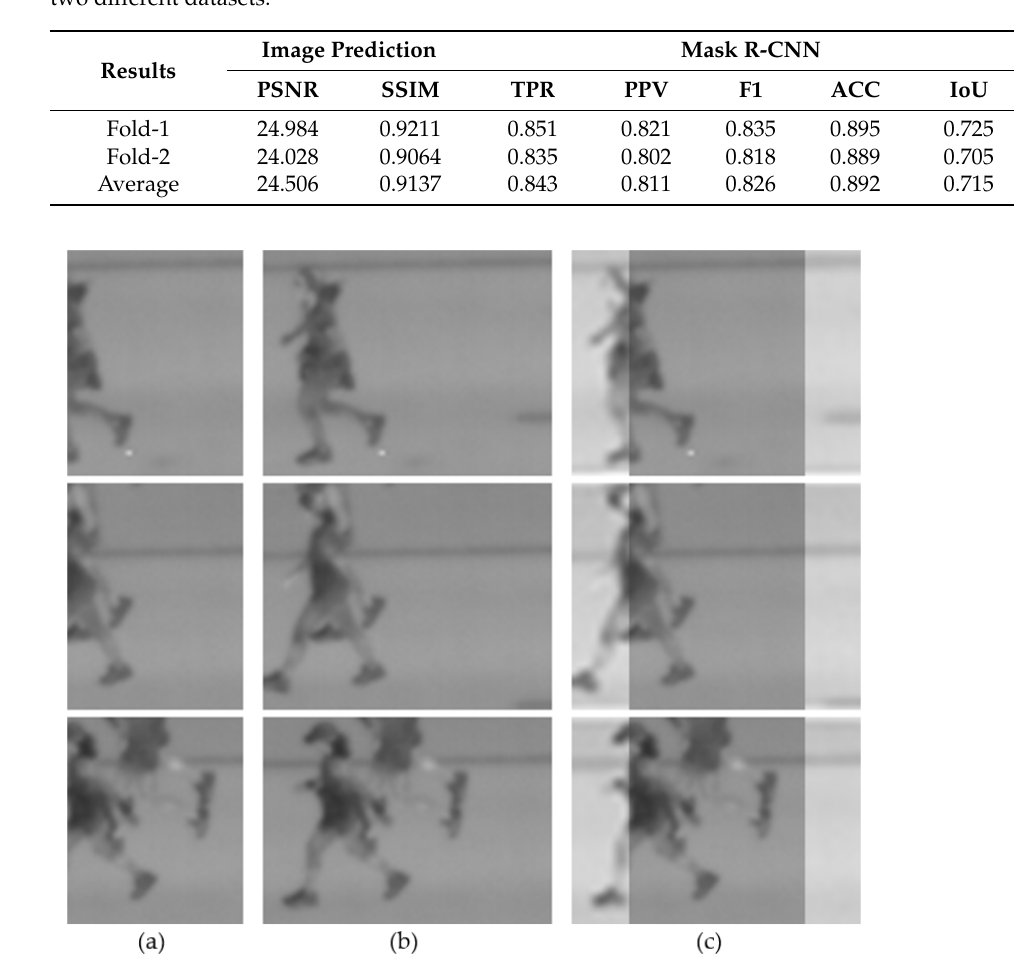
Figure 18. Example images of image prediction from fold-1: ( a ) original images; ( b ) GT images; ( c ) images predicted by the proposed method.